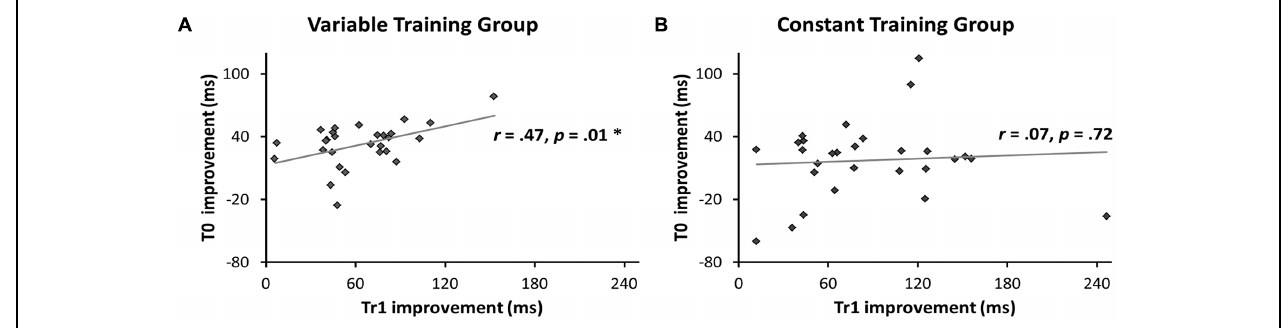
FIGURE 6 | Correlations between improvement scores on the training sequence Tr1 and the transfer sequence T0. Improvement scores were based on RT differences between the first block and the Transfer block of each sequence. Correlations between improvement scores for Tr1 and T0 were calculated separately for the Variable (A) and the Constant (B) group. Only the Variable group showed a significant